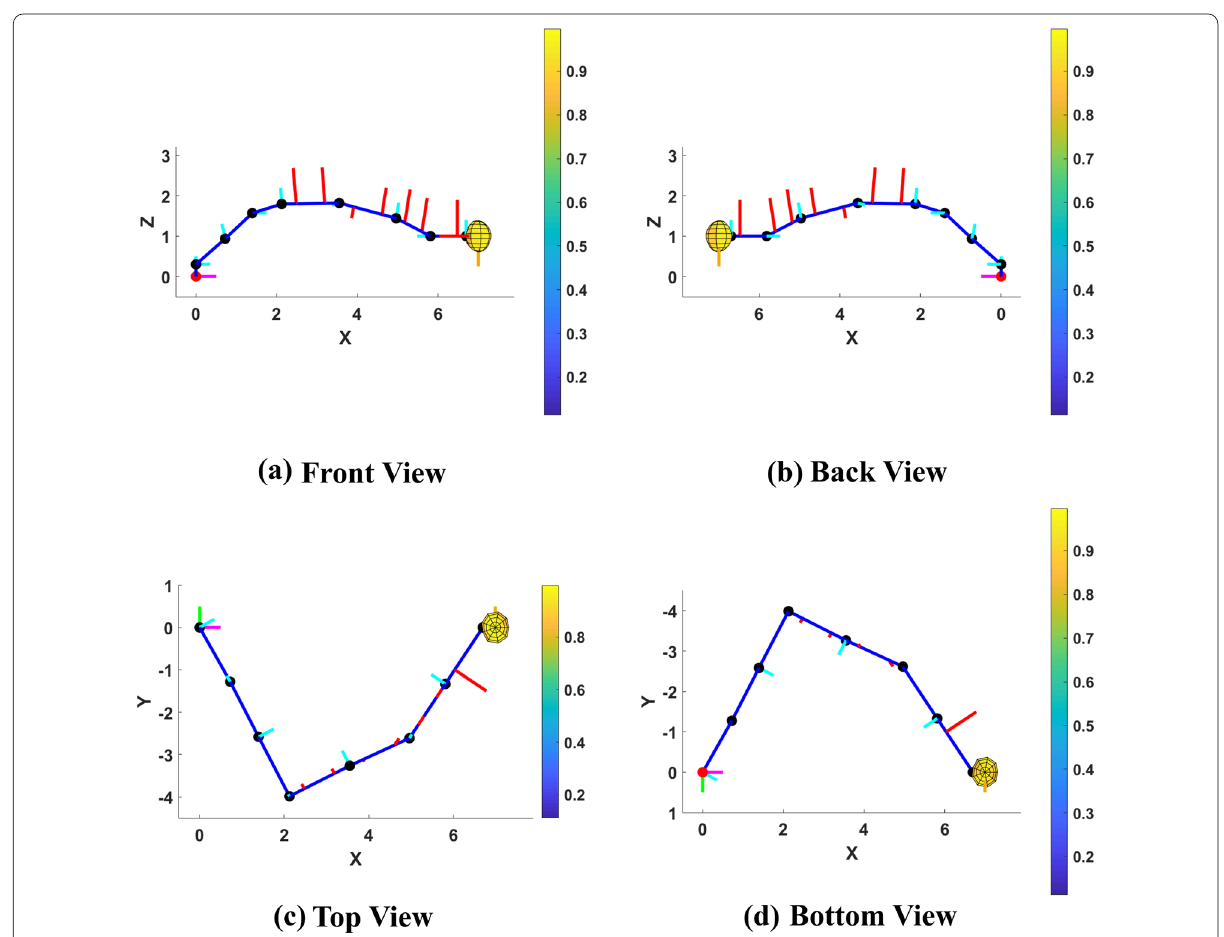
Fig. 10 The front, back, top, and bottom views of the human-experience-based flying watch allocation, end effector reaction force, and the corresponding average TDS in the object manipulation mission. a Front view. b Back view. c Top view. d Bottom